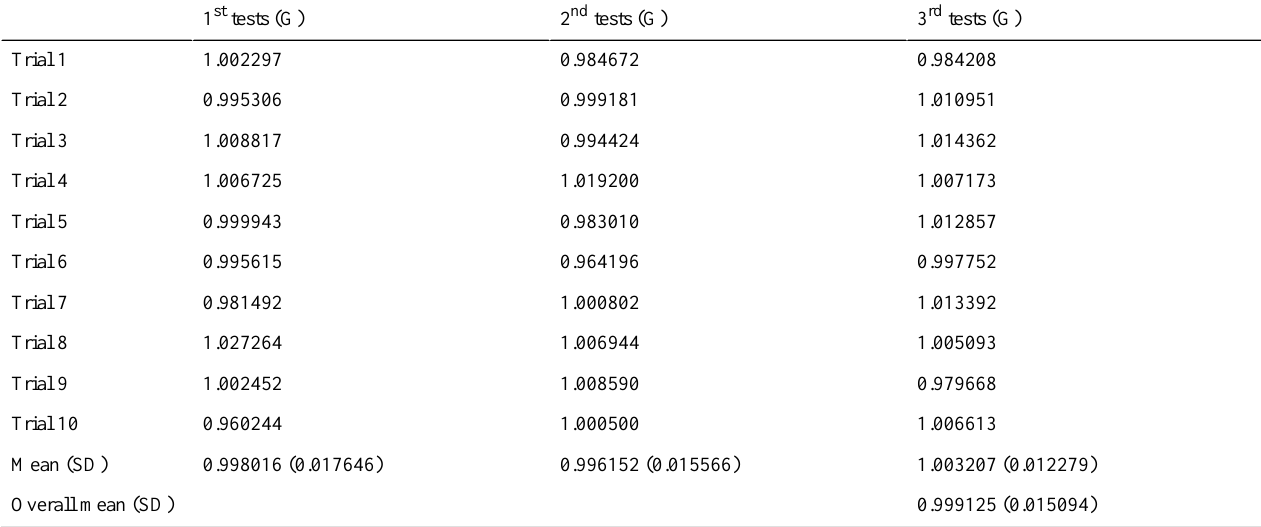
Table 1. Mean accelerations and standard deviations of the device as a function of the device